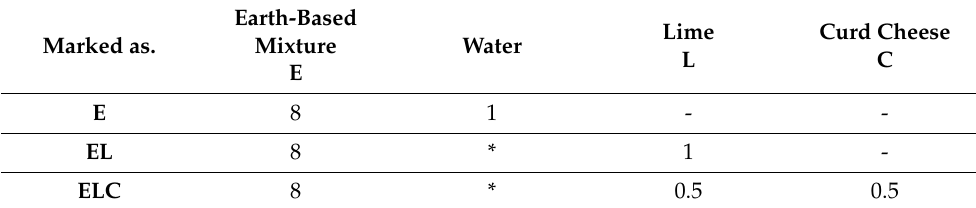
Table 2. Formulas of the tested mortars, in parts of Table 1. XRD quantitative analysis of ready mixed earth-based dry product.